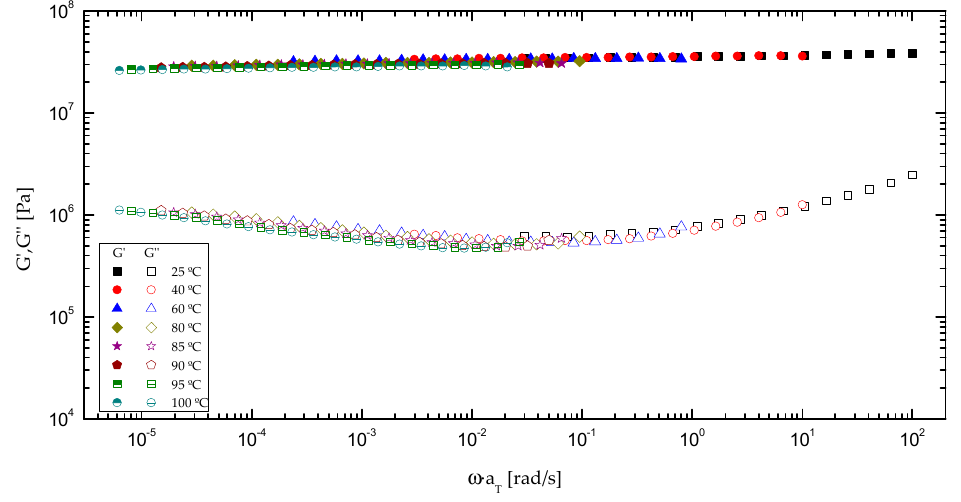
Figure 6. t – T superposition for formulation with 50% CO from 25 up to 100 °C temperature.